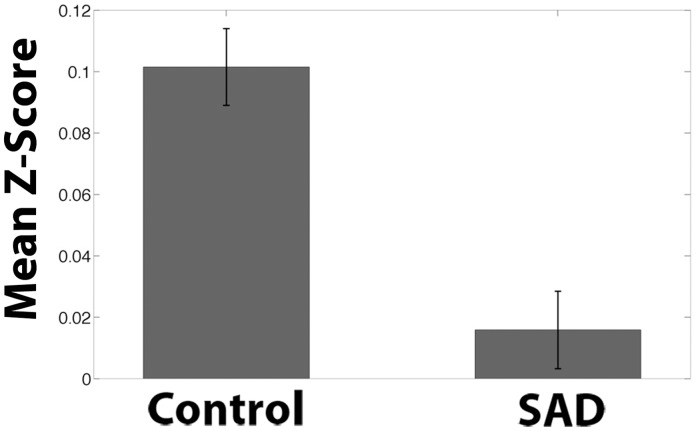
Nucleus Accumbens Seed Functional Connectivity Network Z-Scores of Control > SAD.Mean Fisher transformed correlation values for resting-state connectivity for ventromedial prefrontal cortex cluster from Fig 2C showing significant difference for Control group > SAD group with bilateral nucleus accumbens seed from Fig 1. Peak voxel (MNI coordinates): (30, 12, -6). Bars represent mean connectivity for each group for the ventromedial prefrontal cluster from Fig 2C. One-sample t-test relative to 0: Control: p < .0001; SAD: p = .22. Error bars represent standard errors.